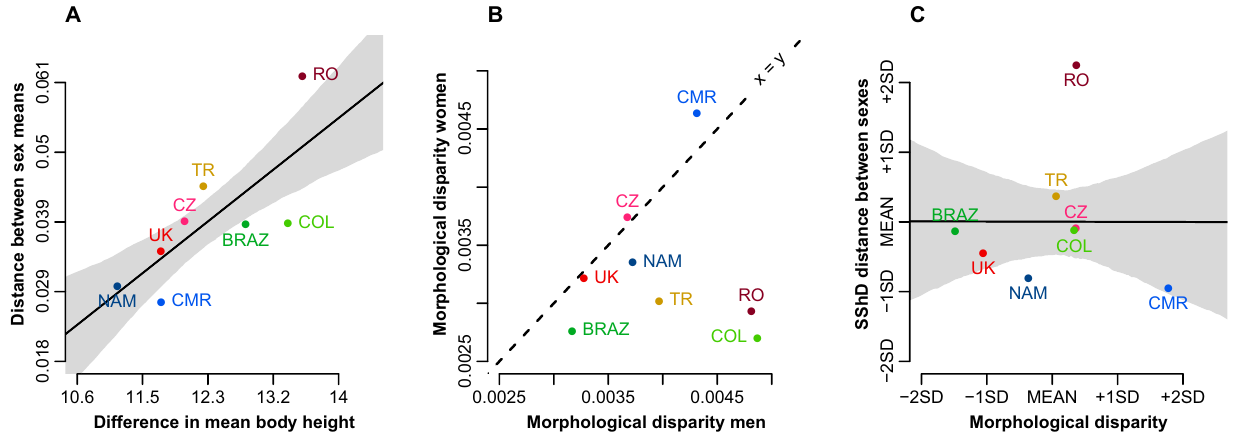
Figure 6. Relationship between difference in sex-specific average statures (x-axis) and average morphological distance between male and female face (y-axis). The difference in body height predicts the distance between the mean facial shape of men and women. All European countries have higher facial dimorphism than expected ( A ). Faces of men are morphologically more variable than faces of women ( B ); total SShD is independent of morphological disparity ( C ). Shaded bounds indicate 89% compatibility corridors of the regression line.